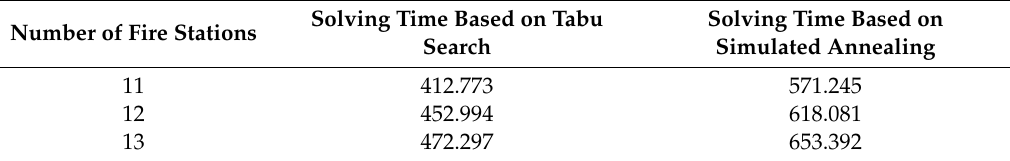
Table 7. Comparison of the average problem-solving time in